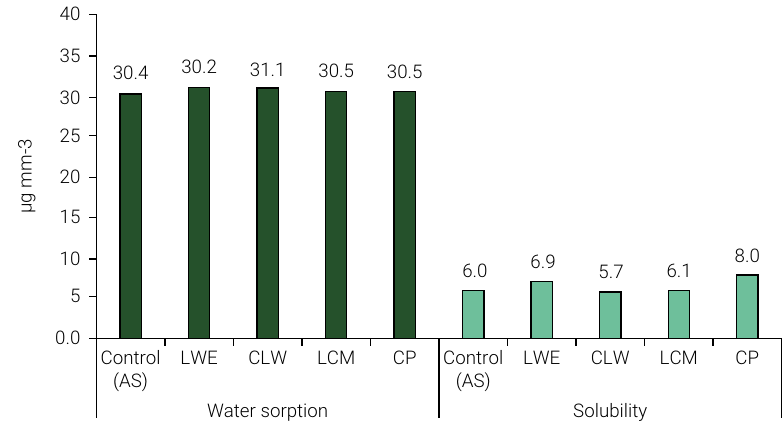
Figure 3. Color change (∆E*) of the nanocomposite Filtek Z350 after application protocol in whitening and conventional mouth rinses